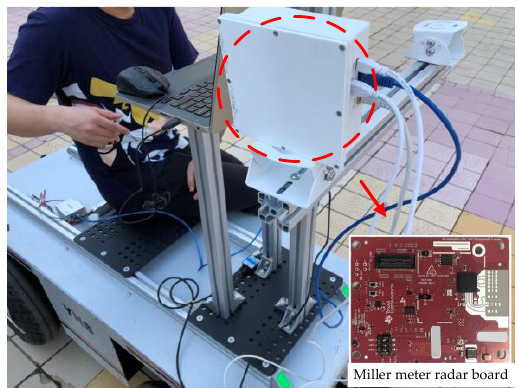
Remote Sens. 2023 , 15 , x FOR PEER REVIEW Figure 13. Experimental system of automotive SAR. Figure 13. Experimental system of automotive SAR.